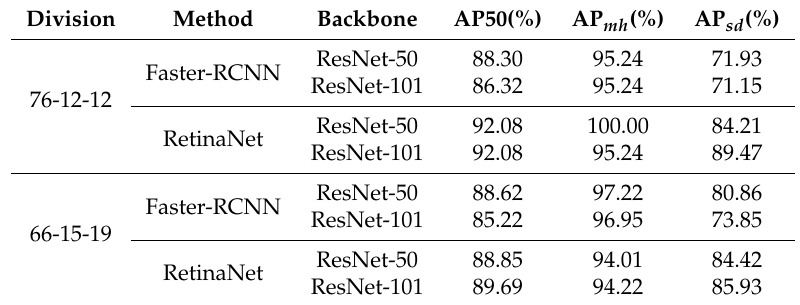
Table 2. Average precision values to AP50 and to classes manhole ( AP mh ) and storm-drain ( AP sd